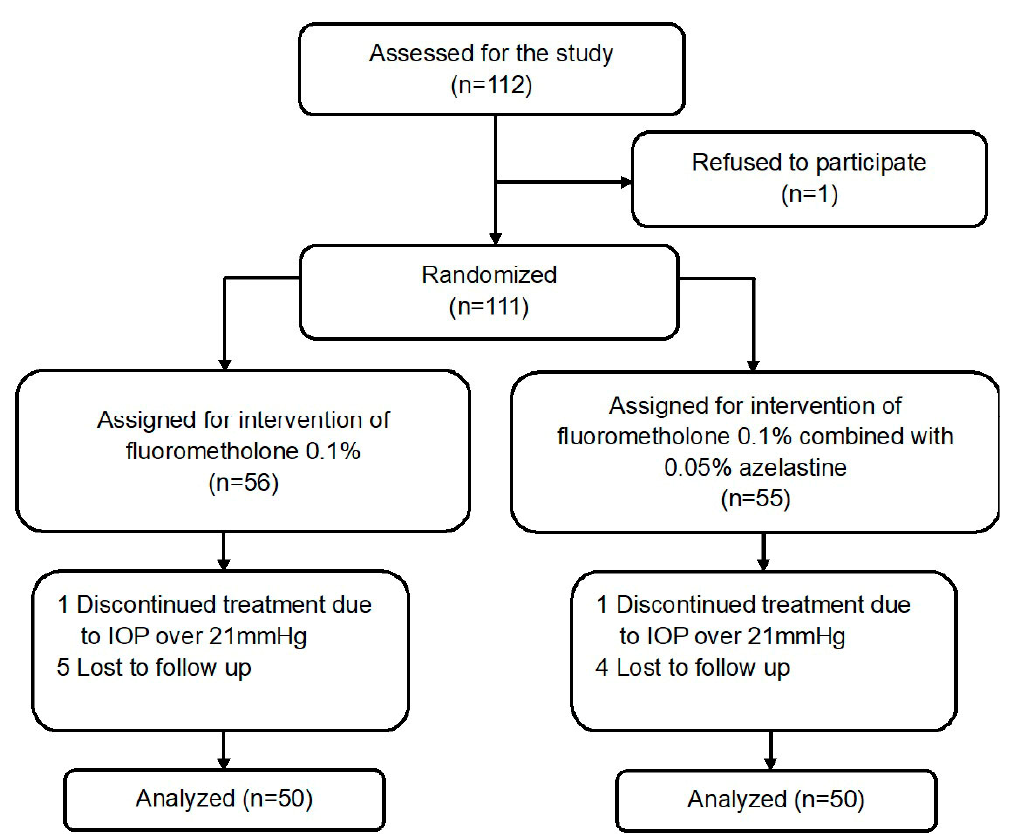
Figure 1. Participant